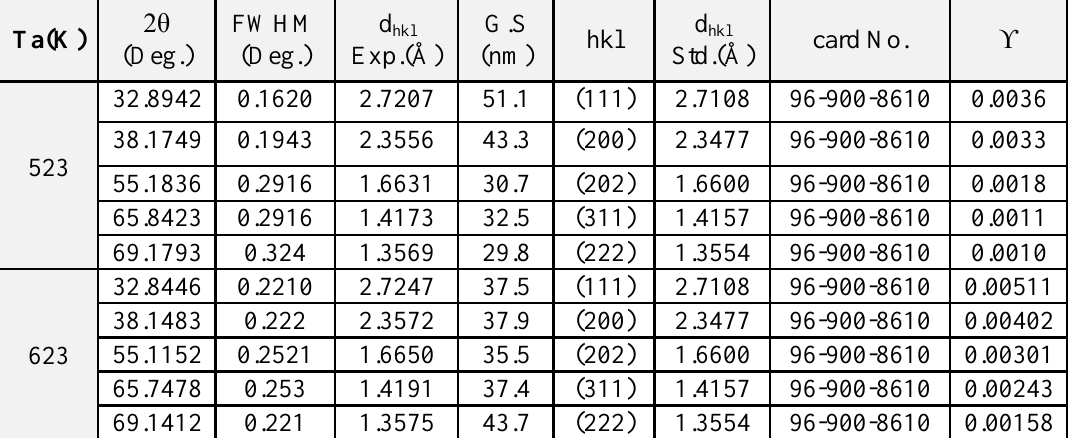
Table 2: XRD peaks, standard and experimental d deposited by voltage (1200)Volt annealed at (523 and 623) K.